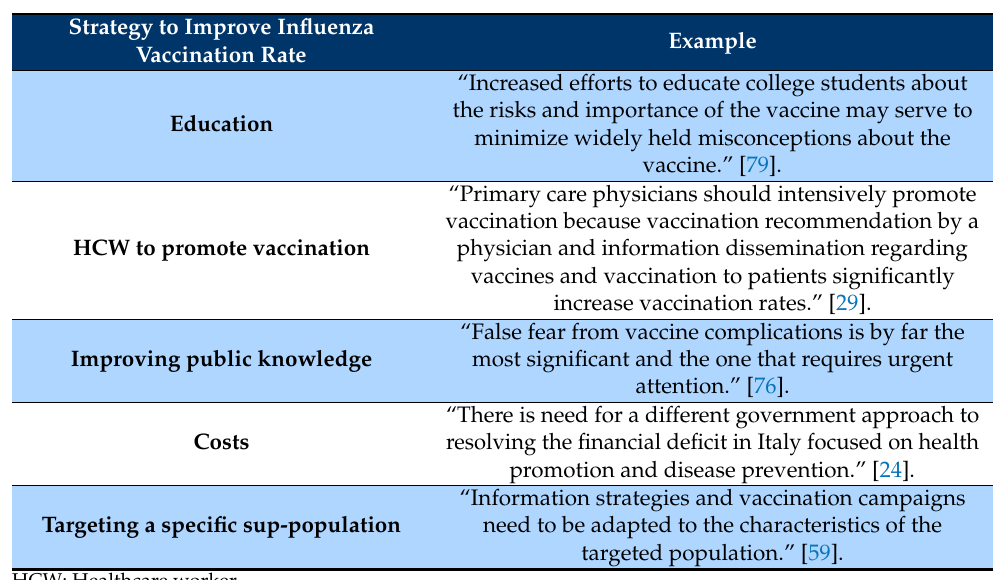
Figure 5. Strategies to overcome barriers to influenza vaccination. HCW: Healthcare worker. Table 6. Strategies to improve influenza vaccination